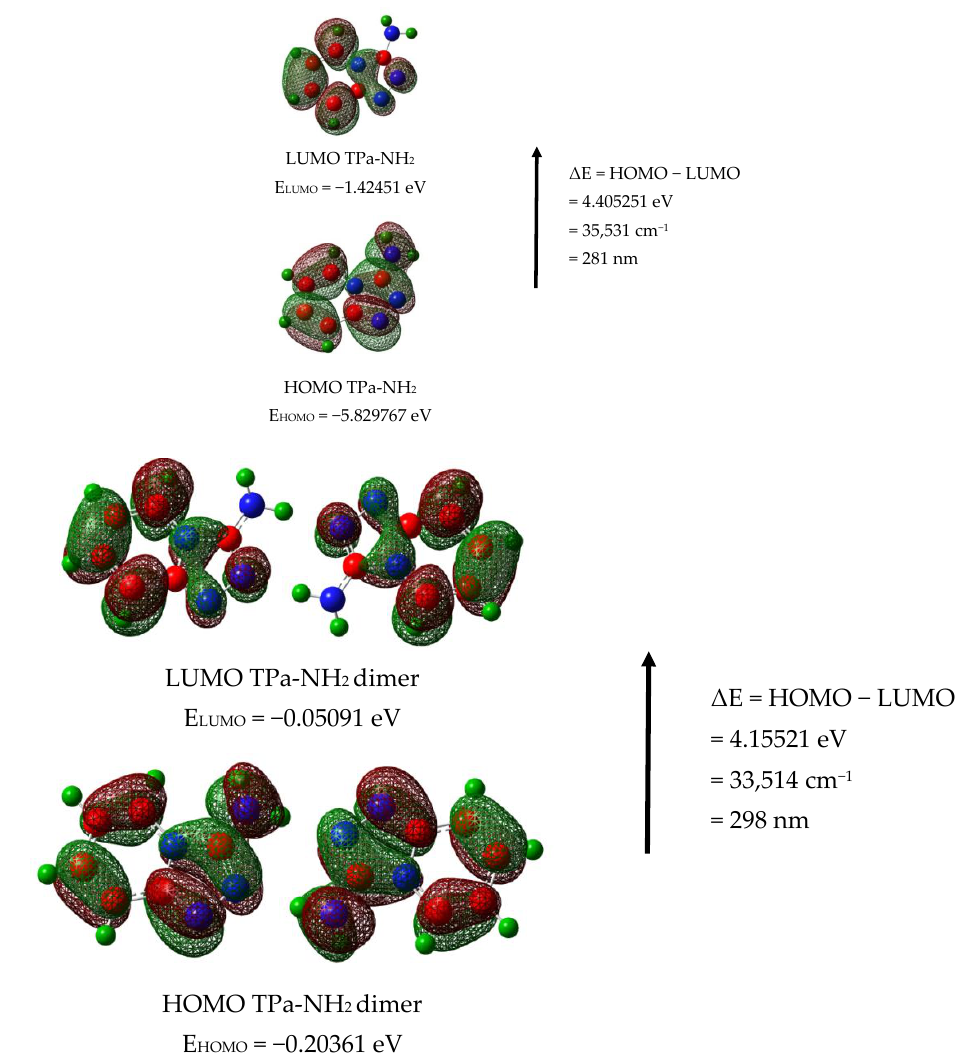
Figure 9. HOMO and LUMO molecular orbitals for the TPa-NH 2 monomer and dimer. Some information follows from the luminescence spectrum measured for the title compound (Figure 10). Its emission spectrum contains two bands: a high intensity one at about 460 nm and the second, clearly weaker, at 545 nm. Depending on the wavelength used for the excitation line, the former band is somewhat shifted towards blue. The ob- served bands should be assigned to the π * → n transitions of the pyridine and triazole rings, respectively. The lifetime of the excited state is 3 ns (insert of Figure 10). A com- parison of the absorption and emission spectra allows us to state that the Stokes shift for the measured sample is close to 9410 and 7625 cm −1 , respectively for the triazole and pyridine rings.